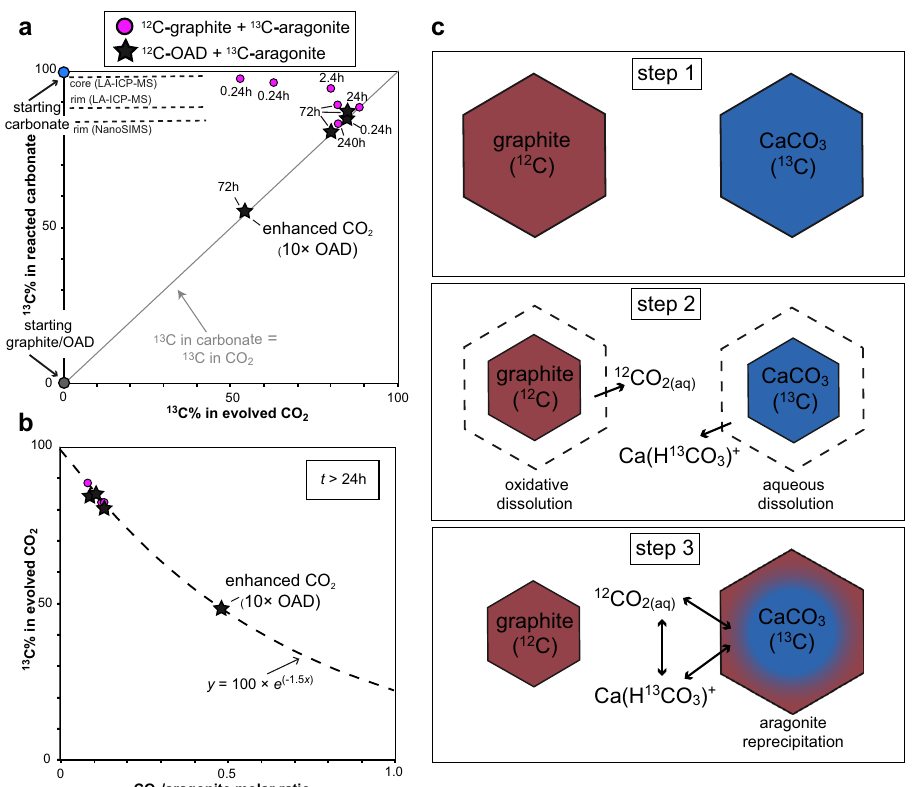
Fig. 3 Isotopic composition of experimental fl uids and solids. a Measured 13 C abundance (%) in CO 2 versus in bulk after-run aragonite. Grey reference line indicates identical 13 C abundances in CO 2 and in bulk aragonite. Starting 13 C% of carbonate and graphite are indicated with blue and grey dots, respectively. Representative point analyses of aragonite cores and rims are shown with black dashed lines. Magenta dots: 13 C-CaCO 3 + graphite runs. Black stars: 13 C-CaCO 3 + oxalic acid di-hydrate (OAD; starting 13 C% is coincident with starting graphite) runs. b CO 2 / 13 C-CaCO 3 molar ratio plotted against 13 C abundance (%) in CO 2 of runs with duration >24 h. Dashed line represents the best fi t of the data using an exponential equation. c Conceptual model for the carbon isotope exchange observed in experiments. At step 1, isotopically pure 12 C-graphite (brown) and 13 C-aragonite (blue) coexist in the same assemblage. As the interaction with water starts (step 2), graphite undergoes oxidative dissolution forming 12 CO 2(aq) , while aragonite dissolves forming Ca(H 13 CO 3 ) + , as predicted by thermodynamic modelling. While graphite oxidative dissolution is self-limiting because the maximum amount of CO 2(aq) in the fl uid is constrained by the redox state of the system, aragonite undergoes a continuous process of dissolution/precipitation (step 3). Therefore, the fi nal isotopic composition of CO 2(aq) , which is in dynamic equilibrium with Ca(HCO 3 ) + and thus with aragonite, becomes rapidly enriched in 13 C ending with 13 C abundances of >80% of the starting 13